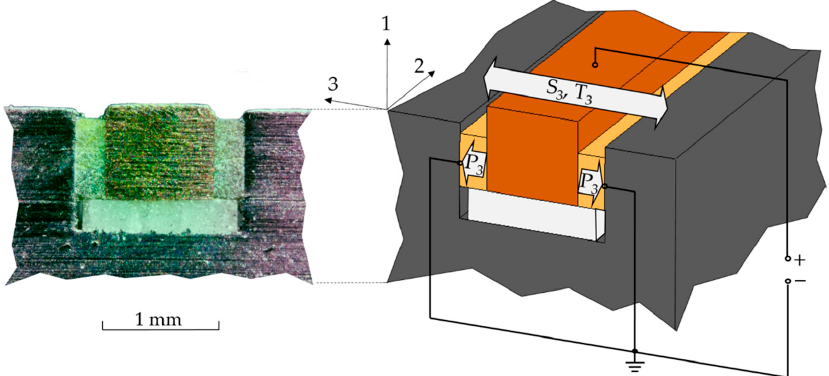
Figure 3. Cross-section ( left ) and functional principle of the SIP ( right ); P 3 : polarization, S 3 : strain, T 3 : tension.